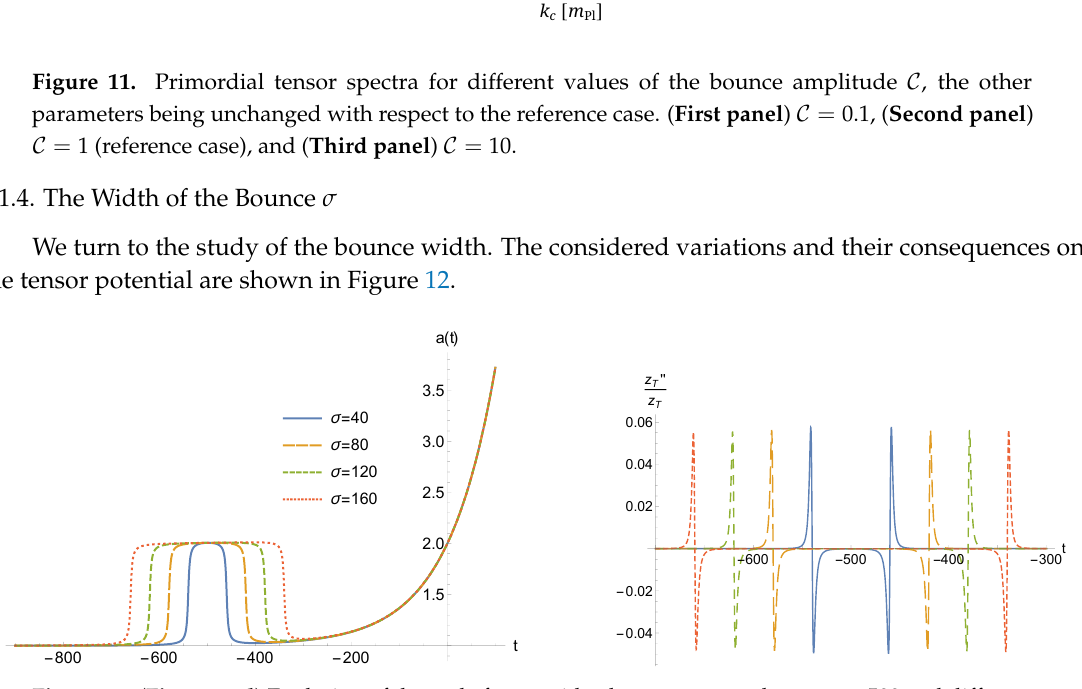
Figure 12. ( First panel ) Evolution of the scale factor with a bounce centered on µ = − 500 and different values of σ . The other parameters of the model are unchanged with respect to the reference case. ( Second panel ) Associated tensor